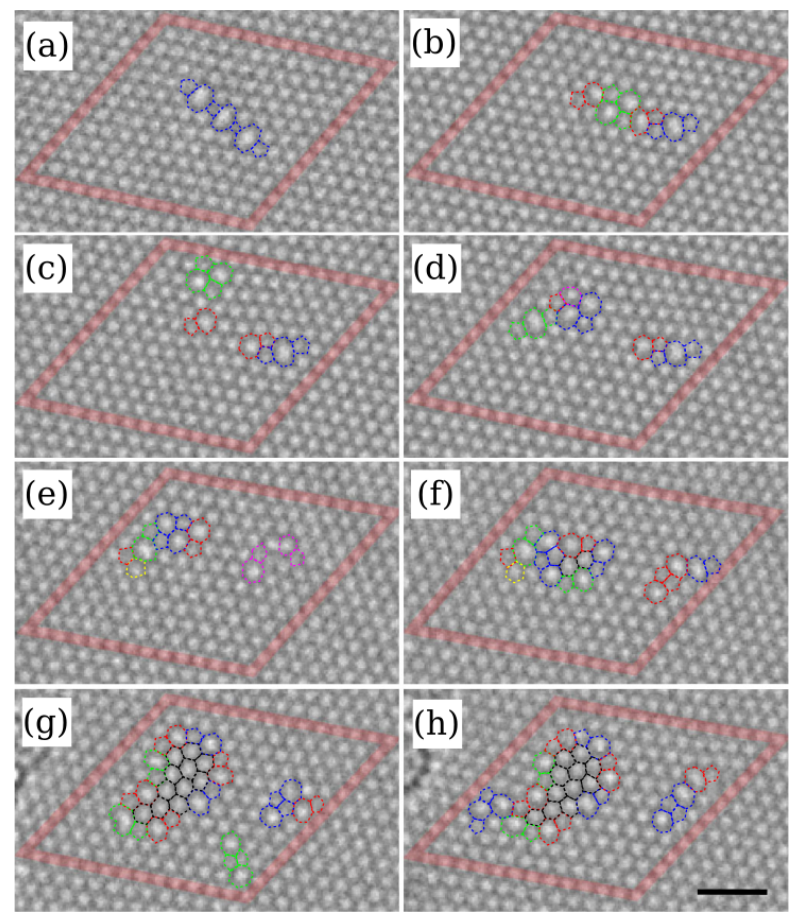
Figure 3. Formation and growth of vacancy-type defects with rotated-hexagon kernels in multivacancy structures. The structural changes were obtained under 100 keV electron irradiation. The images are eight subsequent frames recorded during the experiment. The initial configuration in ( a ) consists of three divacancies in the armchair orientation, in the final configuration ( h ) 24 atoms are missing. Scale bar is 1 nm. Reprinted with permission from Ref. [55], Copyright (2011) by the American Physical